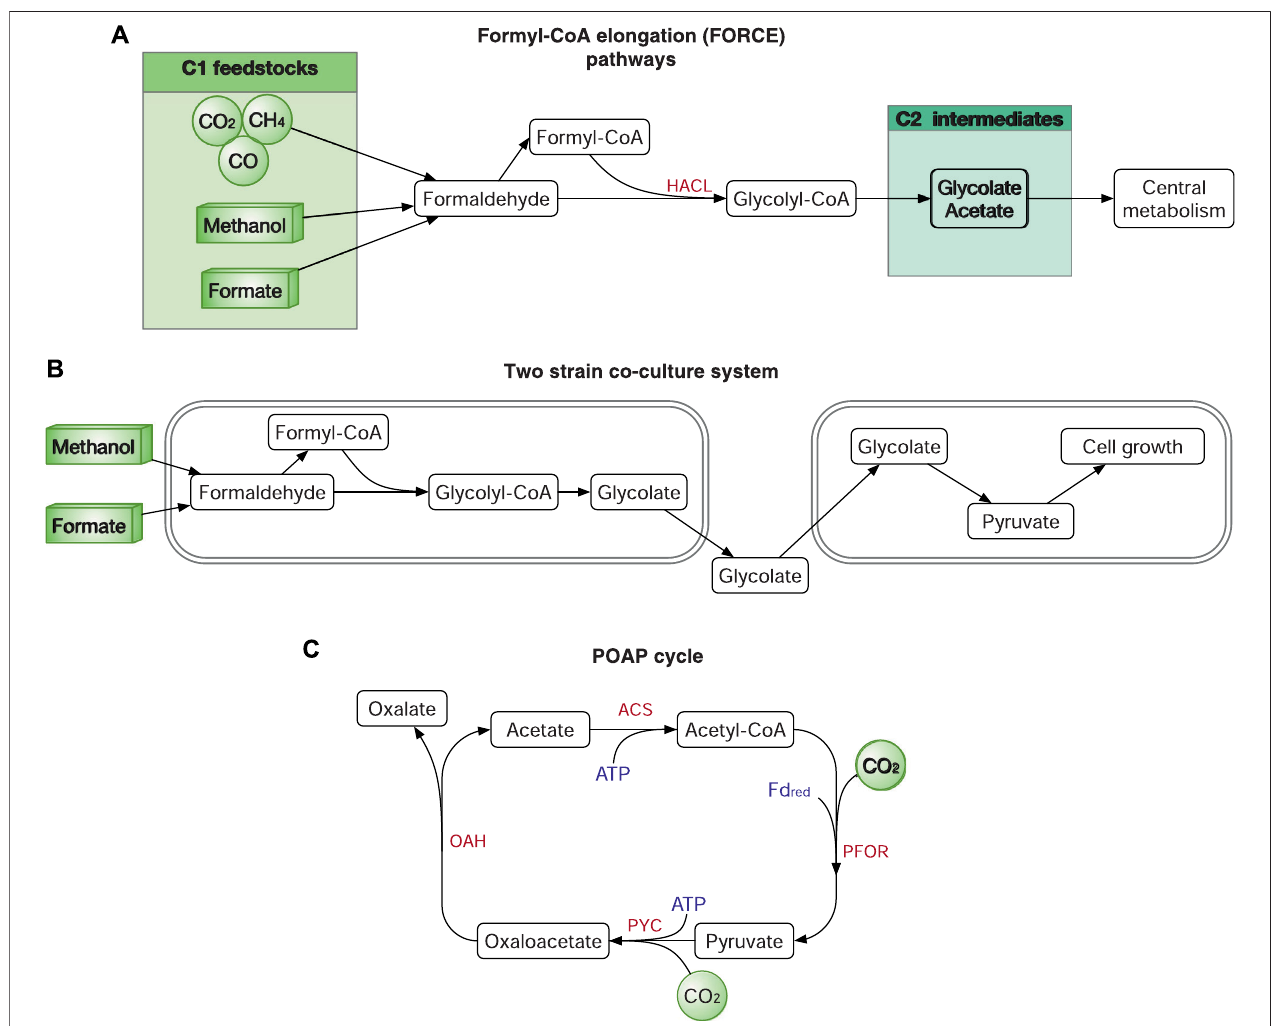
FIGURE8| SyntheticroutesforC1-feedstockassimilation. (A) Syntheticroutesoftheformyl-CoAelongation(FORCE)pathways. (B) Twostrainco-culturesystem using the FORCE pathways. (C) A synthetic CO 2 fi xation pathway, the POAP cycle. Enzymes: HACL, 2-hydroxyacyl-CoA lyase; PYC, pyruvate carboxylase; OAH, oxaloacetate acetylhydrolase; ACS, acetate-CoA ligase, and PFOR, pyruvate synthase. Cofactors: FD red , reduced ferredoxins.